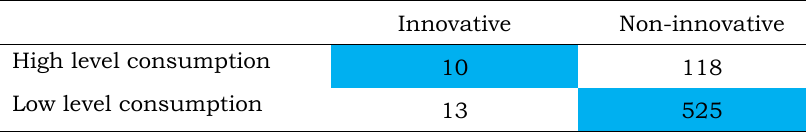
Table 1. Chi-square test of independence for consumption and innovation Low involvement